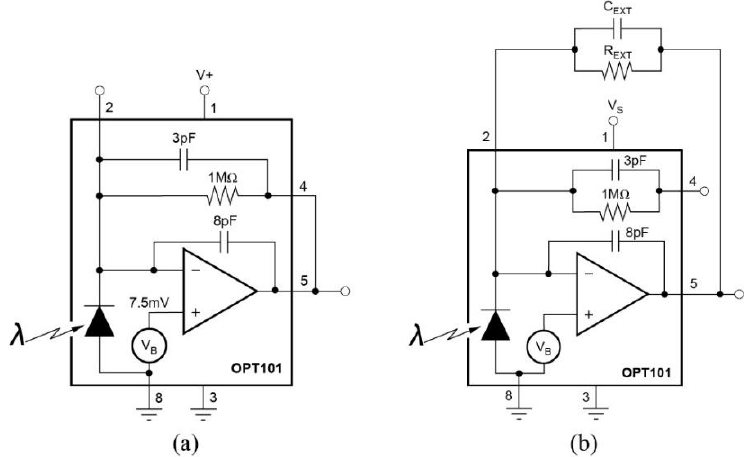
Figure 7. Gain settings of the OPT101. ( a ) Using an internal 1 MΩ feedback resistor by